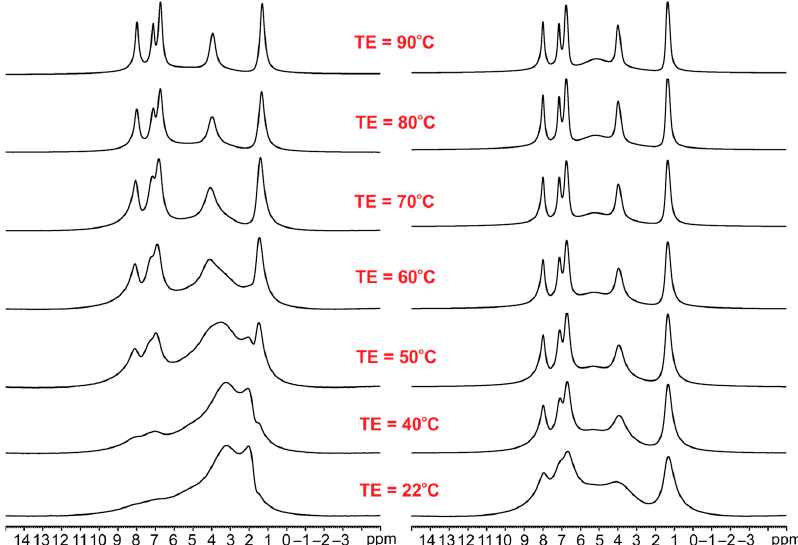
Figure 4. The variable temperature (VT) 1 H MAS spectra of ET/SiO 2(calc) ( left column ) and ET/SiO 2(hydr) ( right column ) recorded with a spinning rate of 8 kHz. The solid-state NMR data are consistent with powder X-ray diffraction (PXRD) measure-